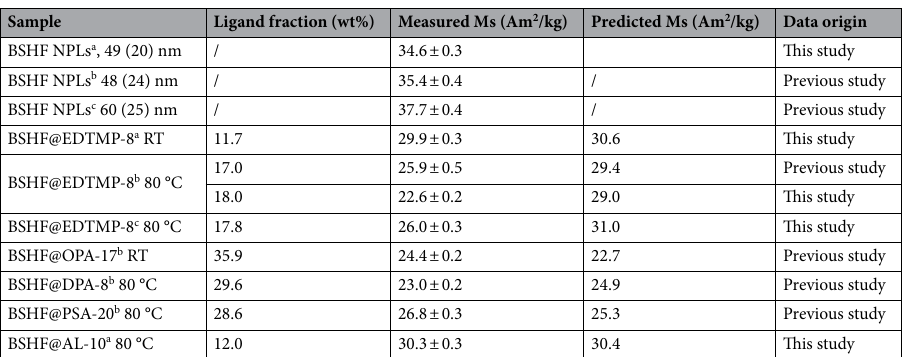
Table 1. Mass fraction of the coated ligand (ω), room-temperature Ms values (i.e., the magnetization at the magnetic field of 1 T = 796 kA/m) of the core and coated particles, and the predicted Ms = ( 1 − ω) Ms core values of the coated NPLs. The coated NPLs were prepared at RT or 80 °C. The listed data were obtained within this and the previous study 12 . a–c Denote different batches of the core BSHF NPLs with a different mean diameter and standard deviation in brackets. Uncertainty of the Ms values originates from the limited precision of the balance (± 1%).